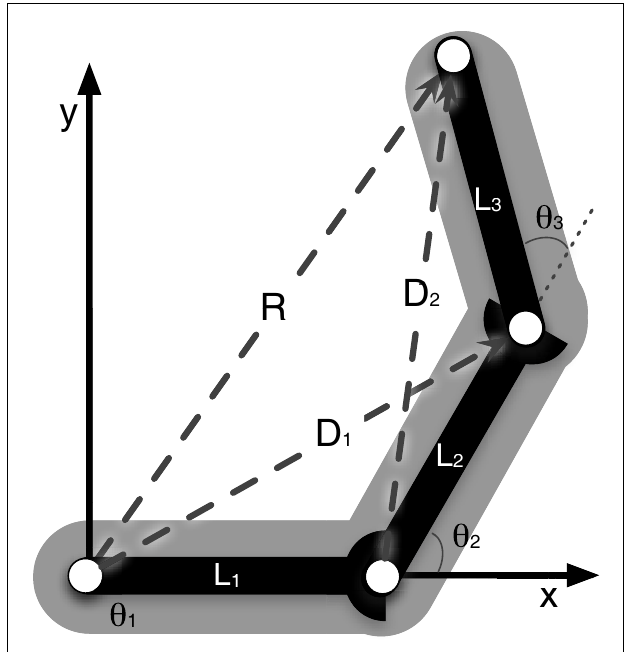
FIGURE 1 |Arm consisting of three segments ( L 1 , L 2 , and L 3 ) that are connected by three hinge joints. The end-effector position is described by the vector R . D 1 and D 2 describe the diagonals.The arm can move in a two-dimensional plane, but has three DoF (joints), one more than